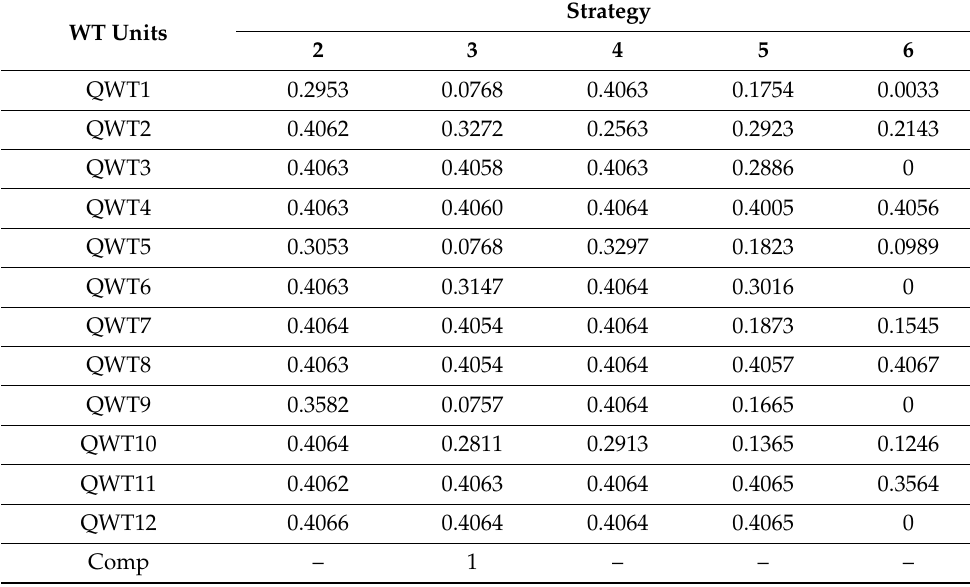
Table 8. Results of option I for reactive power WTs, tap position, and compensation